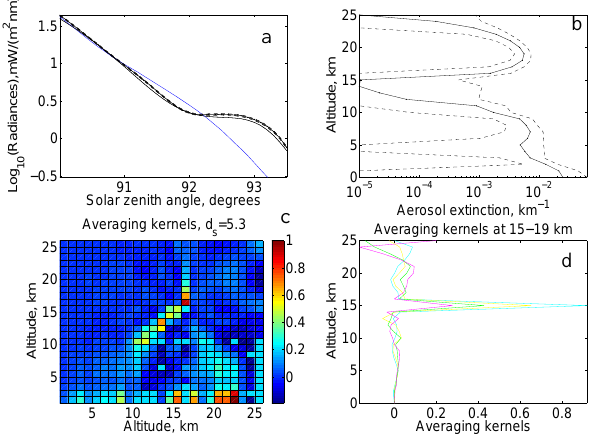
Averaging kernels, d s =5.3